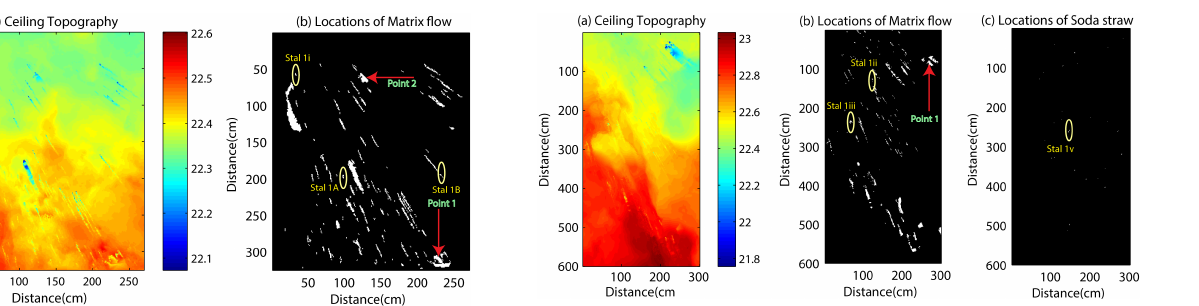
Figure 4. Morphological analysis of the cave ceiling portion con- sisting of sites 1A, 1B, and 1i used to identify different flow patterns (icicle, soda straw, fracture, and combined). (a) Cave ceiling topog- raphy in 2-D. Colour scales represent elevations in metres relative to the T-LiDAR receiver. Stalactites identified in (b) are all catego- rized as icicle flow pattern (Mahmud et al., 2015).